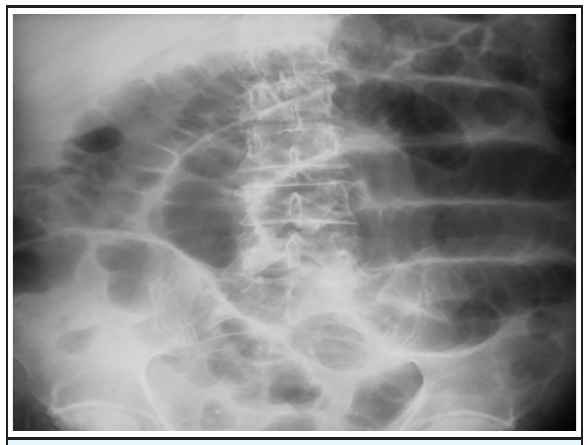
Figure 1a. Supine abdominal radiograph shows multiple dilated loops of small bowel. Valvulae conniventes appear prominent.